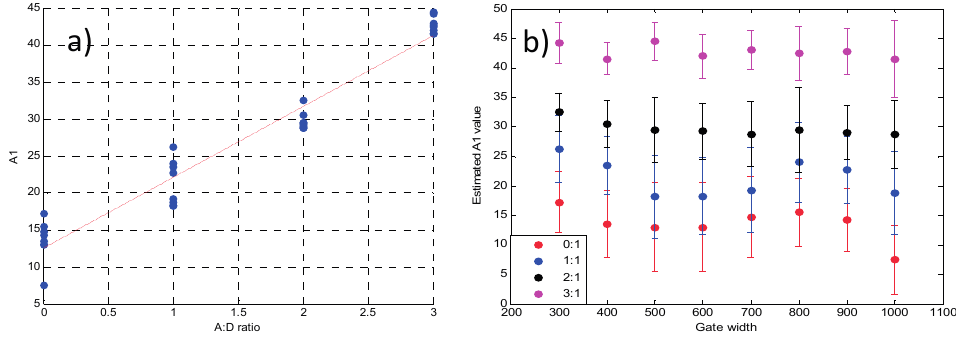
Figure 5. Estimated A 1 values versus ( a ) A:D ratios and ( b ) Gate